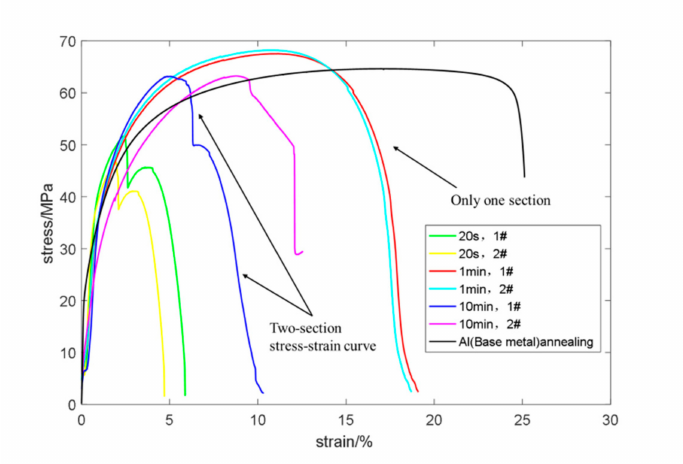
Figure 8. Tensile curves of tension test specimens under di ff erent brazing processes.